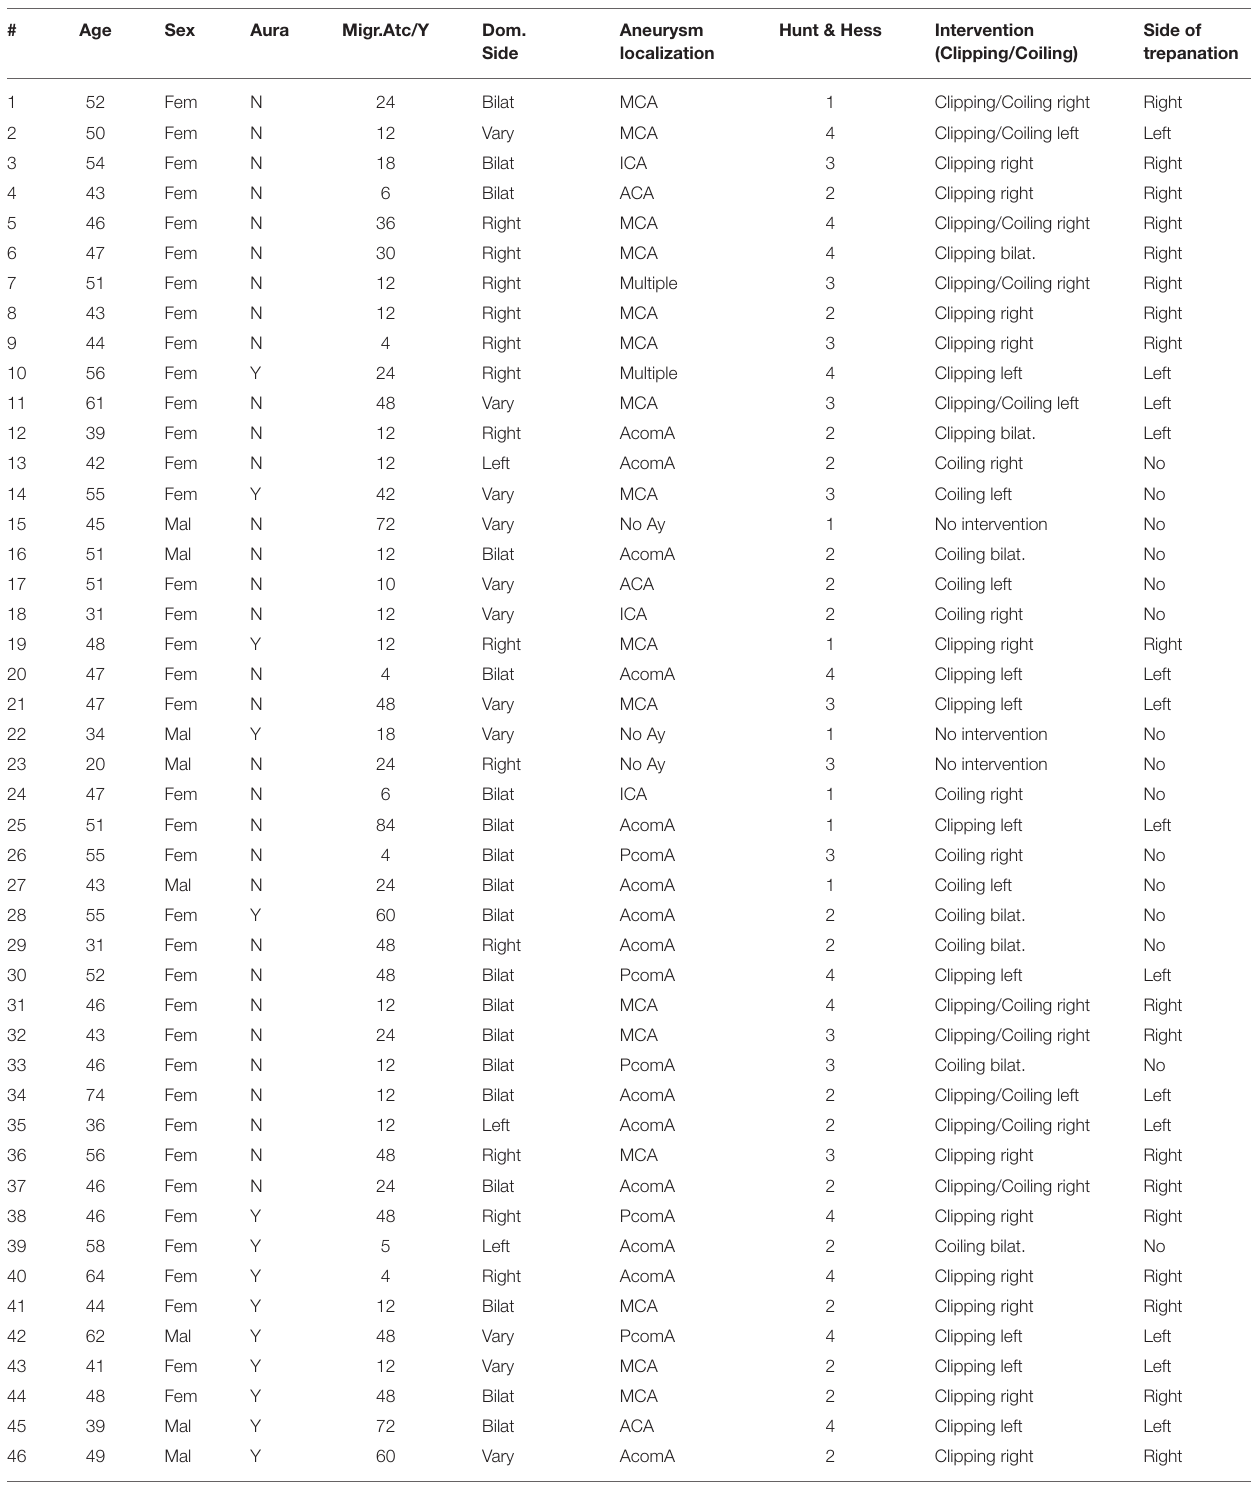
TABLE 2 | Basic characteristics of the included patients.